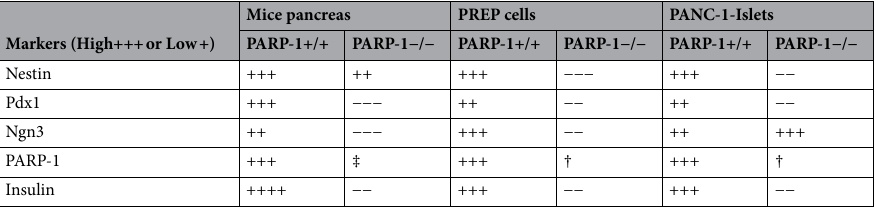
Table 1. Table summarizing all markers expression in Mice Vs PREPs Vs PANC-1-Islets. +++, very high; ++, high; −−−, very low; −−, low; ‡, knockout; †, knockdown expression.